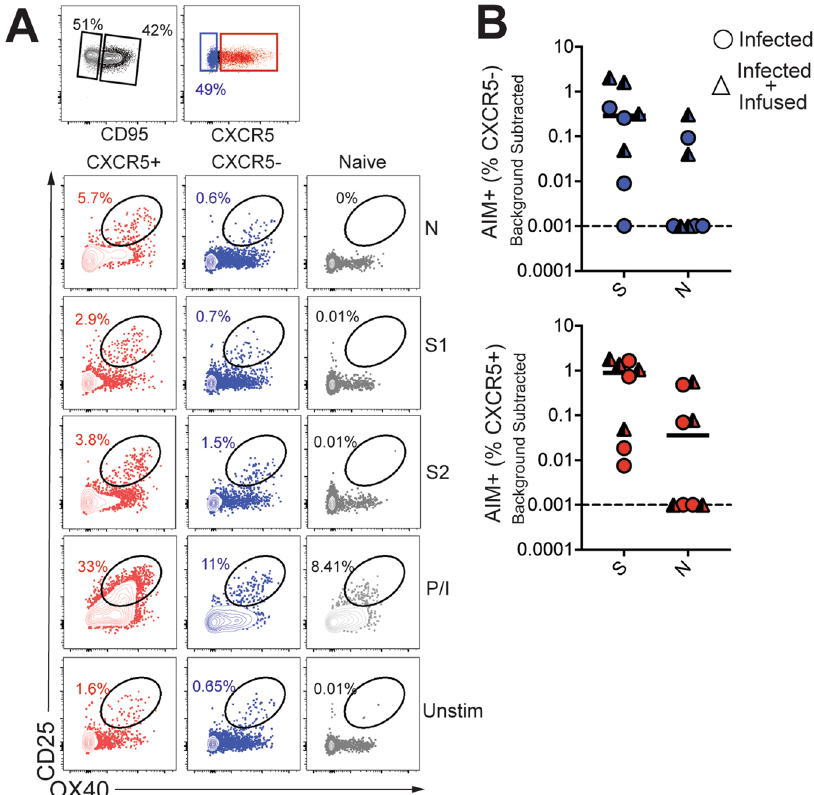
Fig. 5 CD4 T fh cells targeting spike (S) and nucleocapsid (N) in blood following SARS-CoV-2 infection. A Representative gating strategy to identify SARS-CoV-2-speci fi c CD4 T cells following stimulation with spike (S) and nucleocapsid (N) peptide pools in PBMCs. B AIM + CXCR5 − and CXCR5 + CD4 subsets in PBMCs at Day